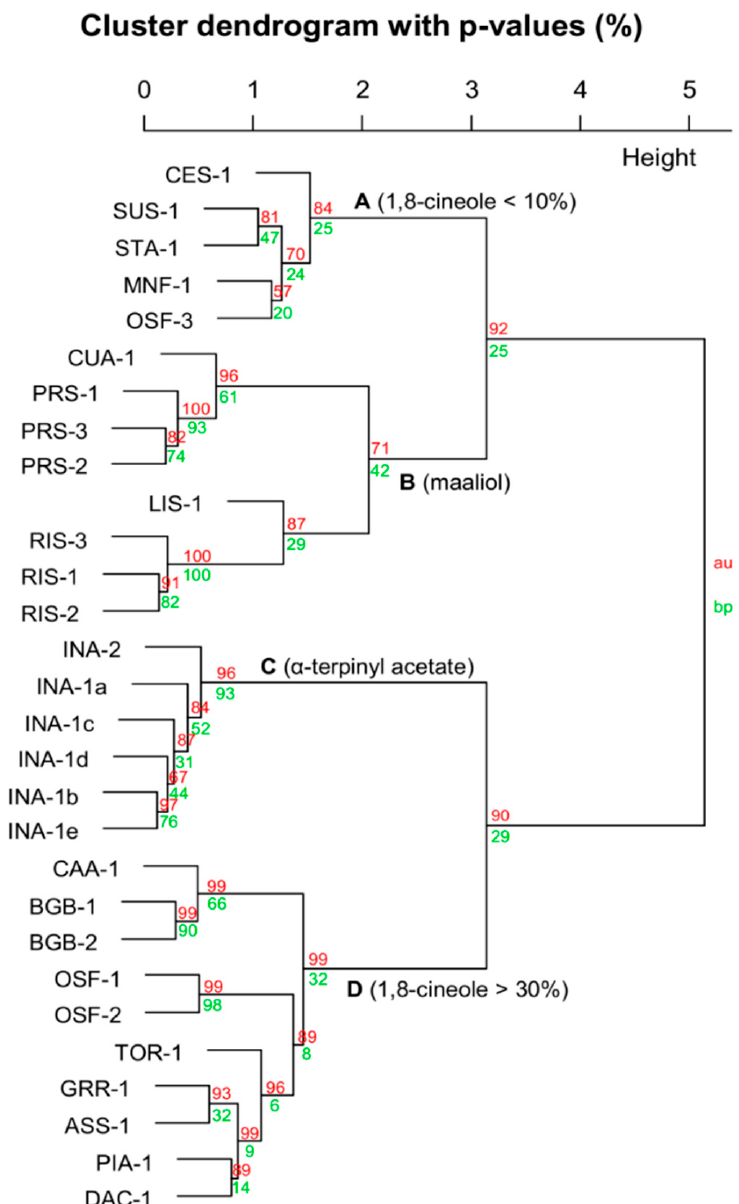
Figure 6. Dendrogram of chemical data from miscellaneous taxa in Prostanthera , not part of the P. ovalifolia or P. rotundiolia group. CES = P. centralis , SUS = P. suborbicularis , STA = P. striatiflora , MNF = P. sp. Minyon Falls, OSF = P. sp. Olney State Forest, CUA = P. cuneata , PRS = P. prunelloides, LIS = P. lithospermoides , RIS = P. ringens , INA = P. incisa , CAA = P. caerulea , BGB = P. sp. Baking Board, TOR = P. sp. Thredbo River, GRR, P. sp. Gibraltar Range, ASS = P. aspalathoides , PIA = P. sp. Piliga, and DAC = P . sp. Dandarha